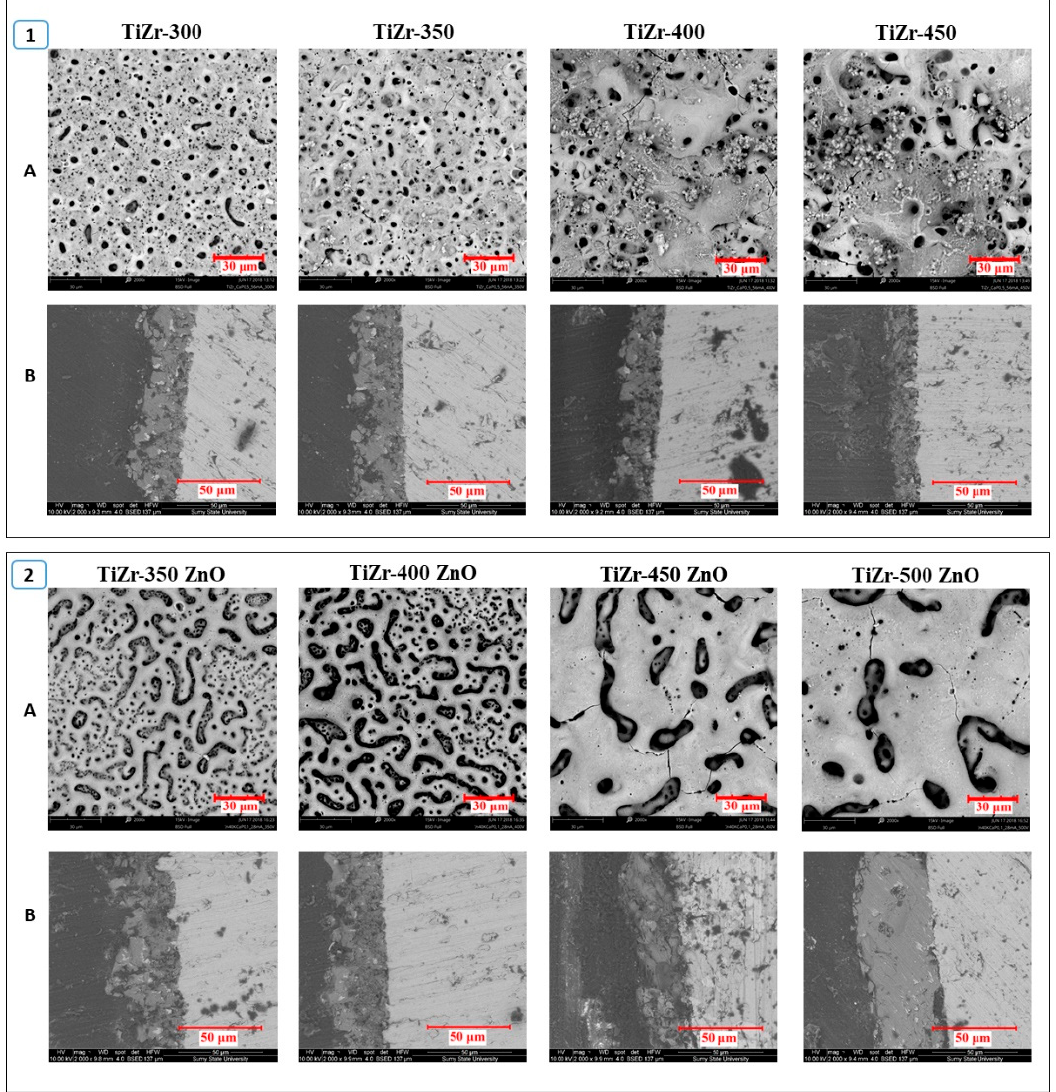
Figure 2. The SEM images microscopy of oxide layer ( A ) and cross-section ( B ) of Plasma Electrolytic Oxidation (PEO)-treated implants in Ca(H 2 PO 2 ) 2 electrolyte bath ( 1 ) and with ZnO nanoparticles (NPs) ( 2 ).